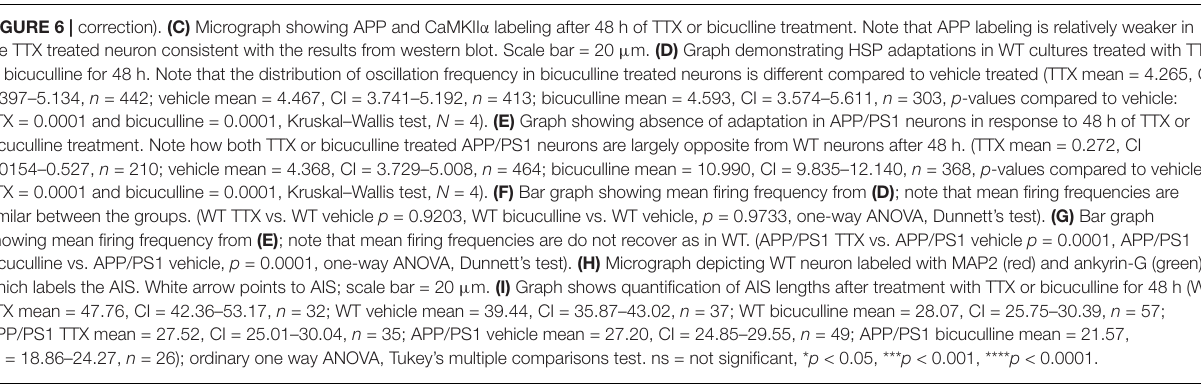
FIGURE 6 | correction). (C) Micrograph showing APP and CaMKII α labeling after 48 h of TTX or bicuclline treatment. Note that APP labeling is relatively weaker in the TTX treated neuron consistent with the results from western blot. Scale bar = 20 µ m. (D) Graph demonstrating HSP adaptations in WT cultures treated with TTX or bicuculline for 48 h. Note that the distribution of oscillation frequency in bicuculline treated neurons is different compared to vehicle treated (TTX mean = 4.265, CI 3.397–5.134, n = 442; vehicle mean = 4.467, CI = 3.741–5.192, n = 413; bicuculline mean = 4.593, CI = 3.574–5.611, n = 303, p -values compared to vehicle: TTX = 0.0001 and bicuculline = 0.0001, Kruskal–Wallis test, N = 4). (E) Graph showing absence of adaptation in APP/PS1 neurons in response to 48 h of TTX or bicuculline treatment. Note how both TTX or bicuculline treated APP/PS1 neurons are largely opposite from WT neurons after 48 h. (TTX mean = 0.272, CI 0.0154–0.527, n = 210; vehicle mean = 4.368, CI = 3.729–5.008, n = 464; bicuculline mean = 10.990, CI = 9.835–12.140, n = 368, p -values compared to vehicle: TTX = 0.0001 and bicuculline = 0.0001, Kruskal–Wallis test, N = 4). (F) Bar graph showing mean firing frequency from (D) ; note that mean firing frequencies